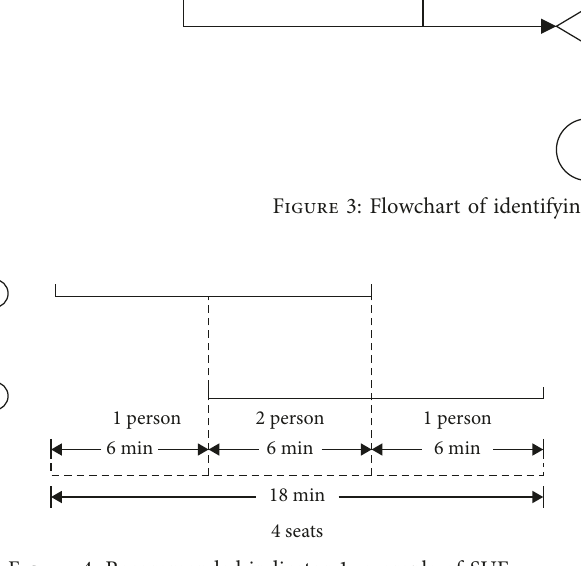
Figure 4: Recommended indicator 1: example of SUE.